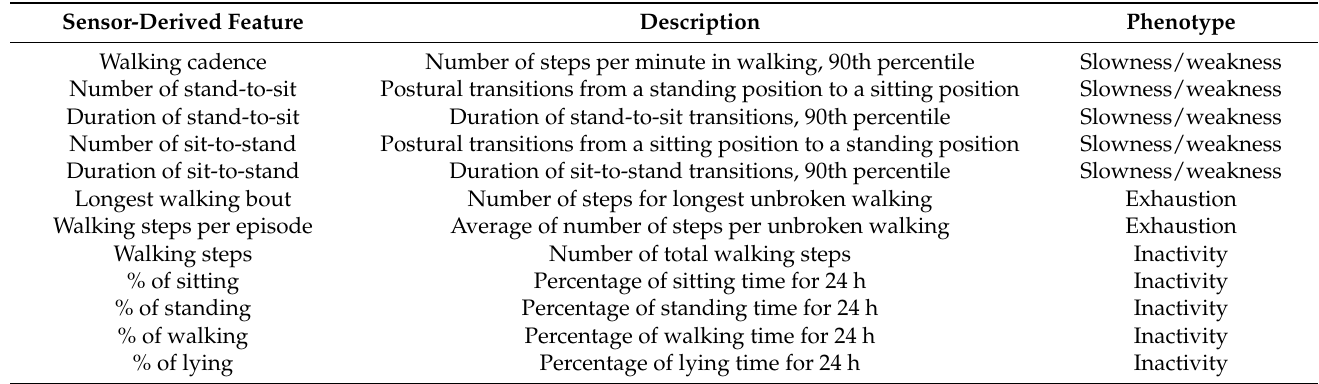
Table 1. Description of 12 sensor -derived features and associated phenotypes.